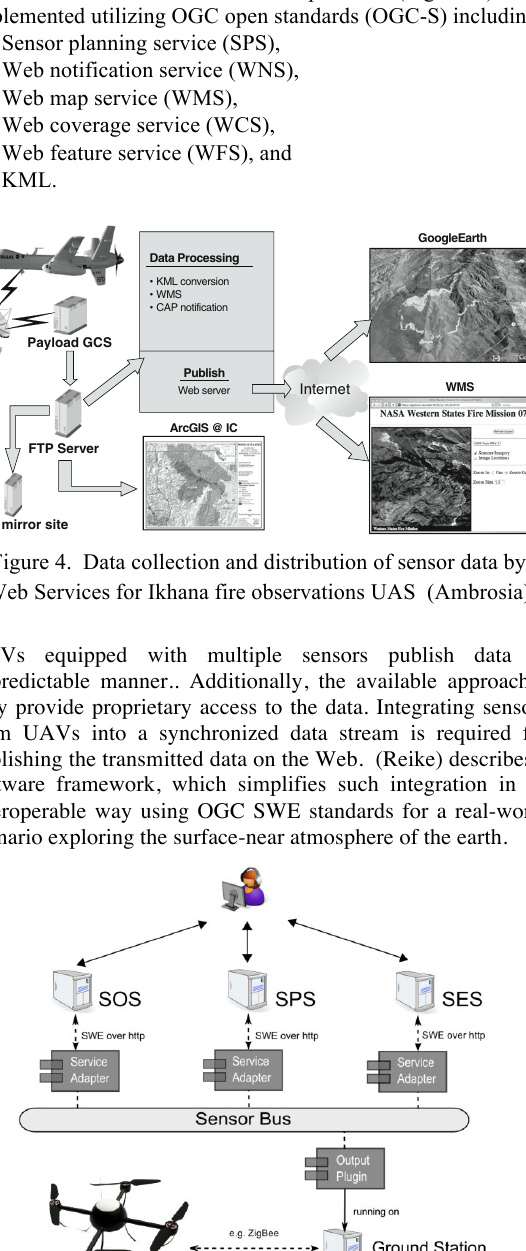
Figure 6: High-level architecture. Figure 5. Framework for UAS using OGC SWE ( Reike